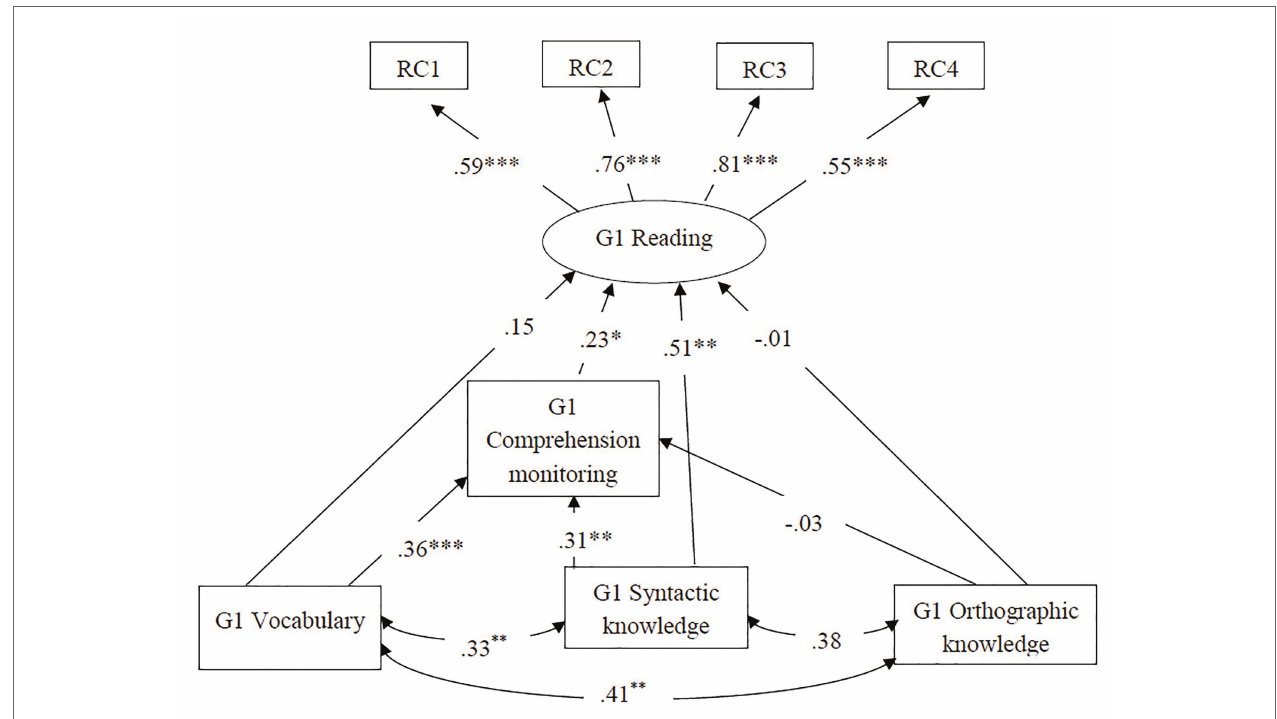
FIGURE 3 | Concurrent relations among language skills, comprehension monitoring, and reading comprehension in Grade 1. Standardized estimates were reported. G1 = Grade 1; RC 1/2/3/4 = Reading comprehension task 1/2/3/4 in Grade 1; * p < 0.05, ** p < 0.01, and *** p < 0.001.